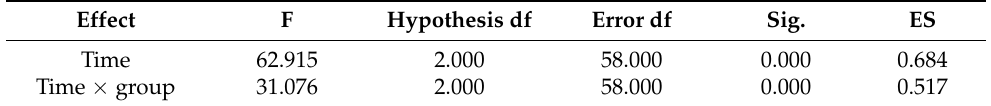
Table 6. Mauchly’s Test of Sphericity. Effect F